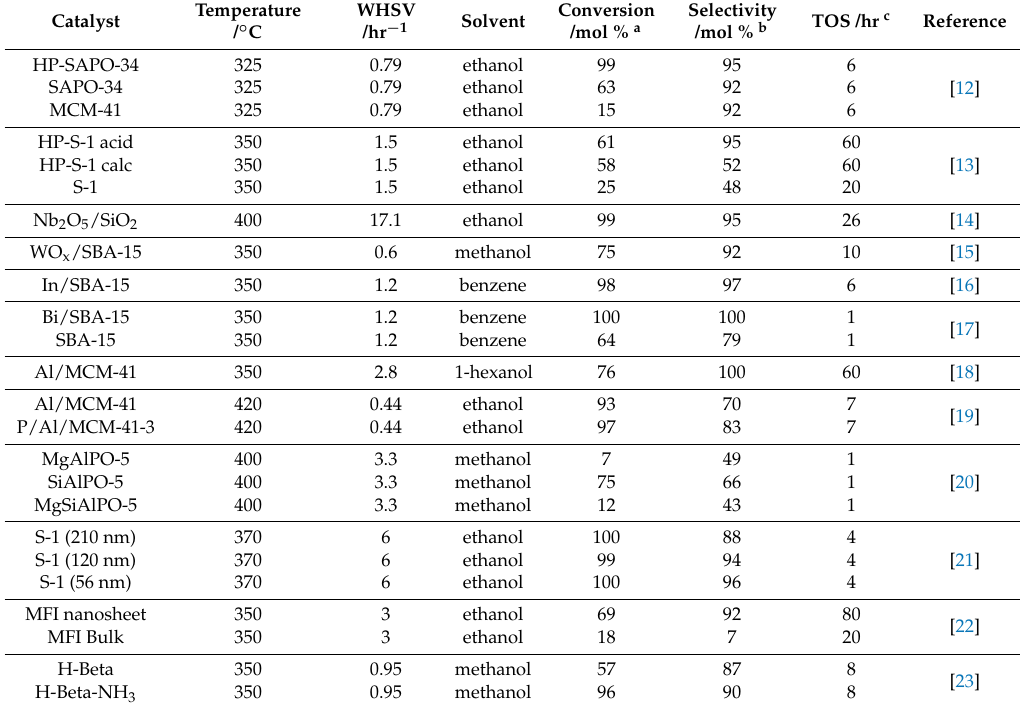
Table 1. An overview of heterogeneous catalysts with reported activity in the vapour-phase Beckmann rearrangement.